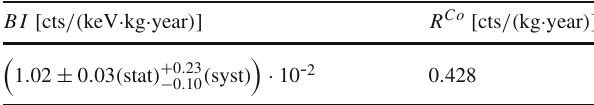
Table 1 Input parameters for the production of toy-MC spectra BI [cts /( keV · kg · year )